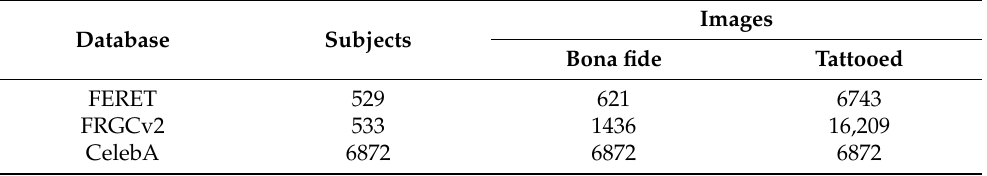
Table 1. Overview of the generated database (before